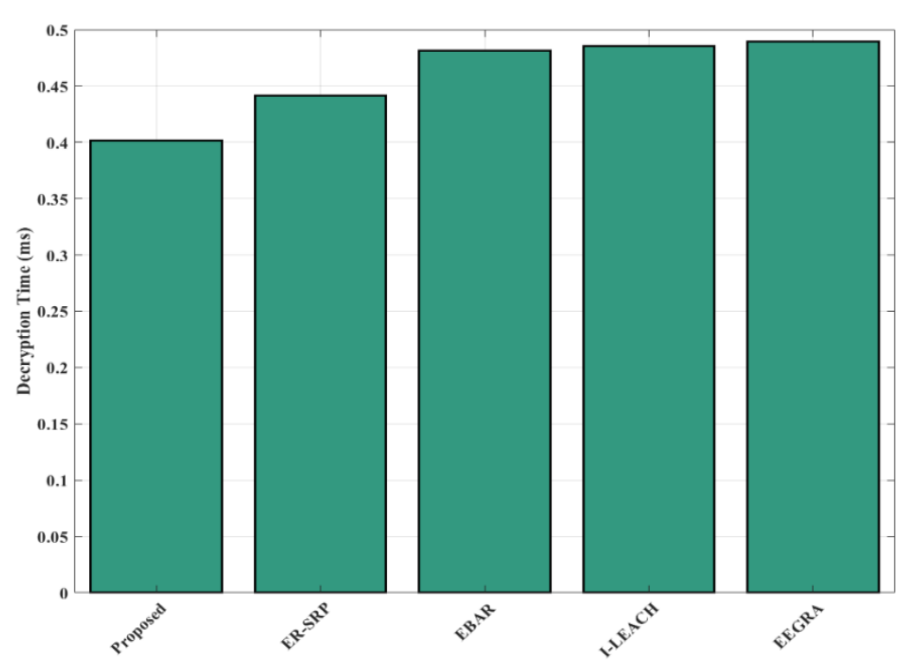
Figure 14. Comparison on the amount of packet received.